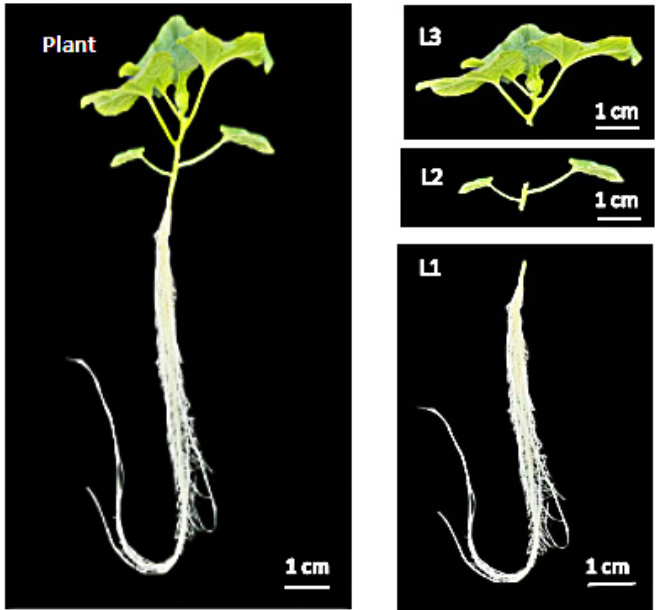
Figure 11 . Sampling site of isotopic 13 CO 2 feeding plant . Figure 11. Sampling site of isotopic 13 CO